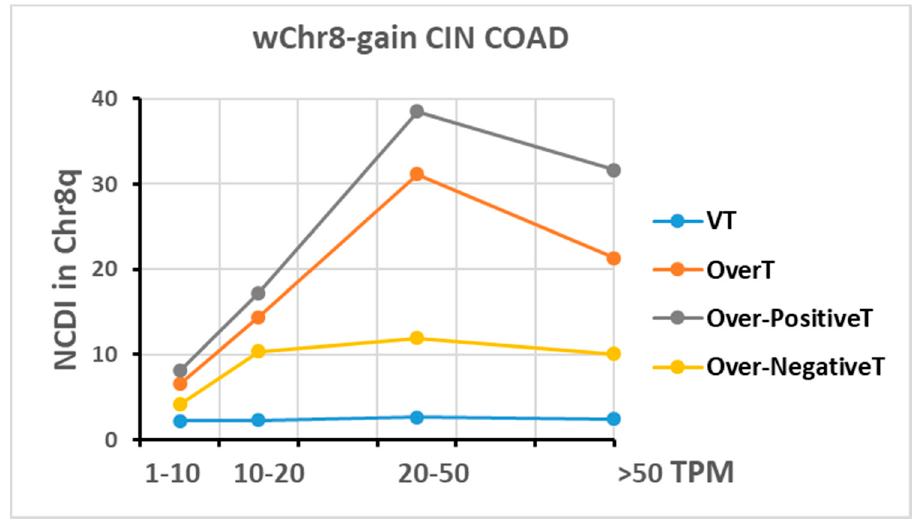
Figure 7. Transcripts are subdivided into different bins according to TPM values as indicated in the x -axis. The NCDI value in Chr8q is reported in the y -axis. Data obtained in the wChr8-gain CIN COAD group are